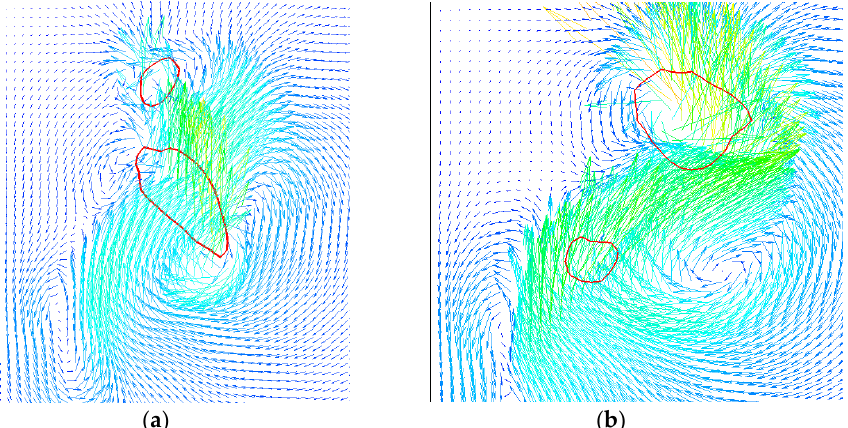
Figure 14. Upward flow field diagram of double bubbles of different sizes near the wall at 110 ms: ( a ) Upper small and lower large, ( b ) Upper big and lower small. (3) The upper large and the lower small double bubbles